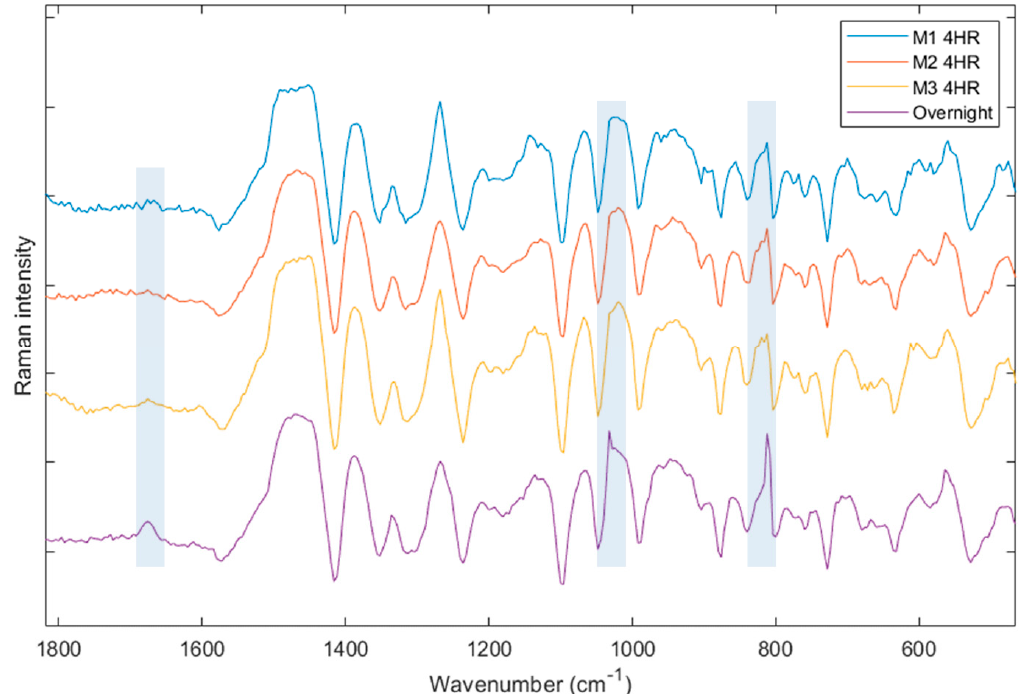
Figure 7. SERS spectra of MeSA VOCs according to the collection times. M1 4HR: Mixture with 1 mg of polymer for 4 h, M2 4HR: Mixture with 2 of mg polymer for 4 h, M3 4HR: Mixture with 3 mg of polymer for 4 h, overnight: Averaged over three concentrations overnight. MeSA standard Raman spectrum is available in the Supplementary Materials, Figure S1.